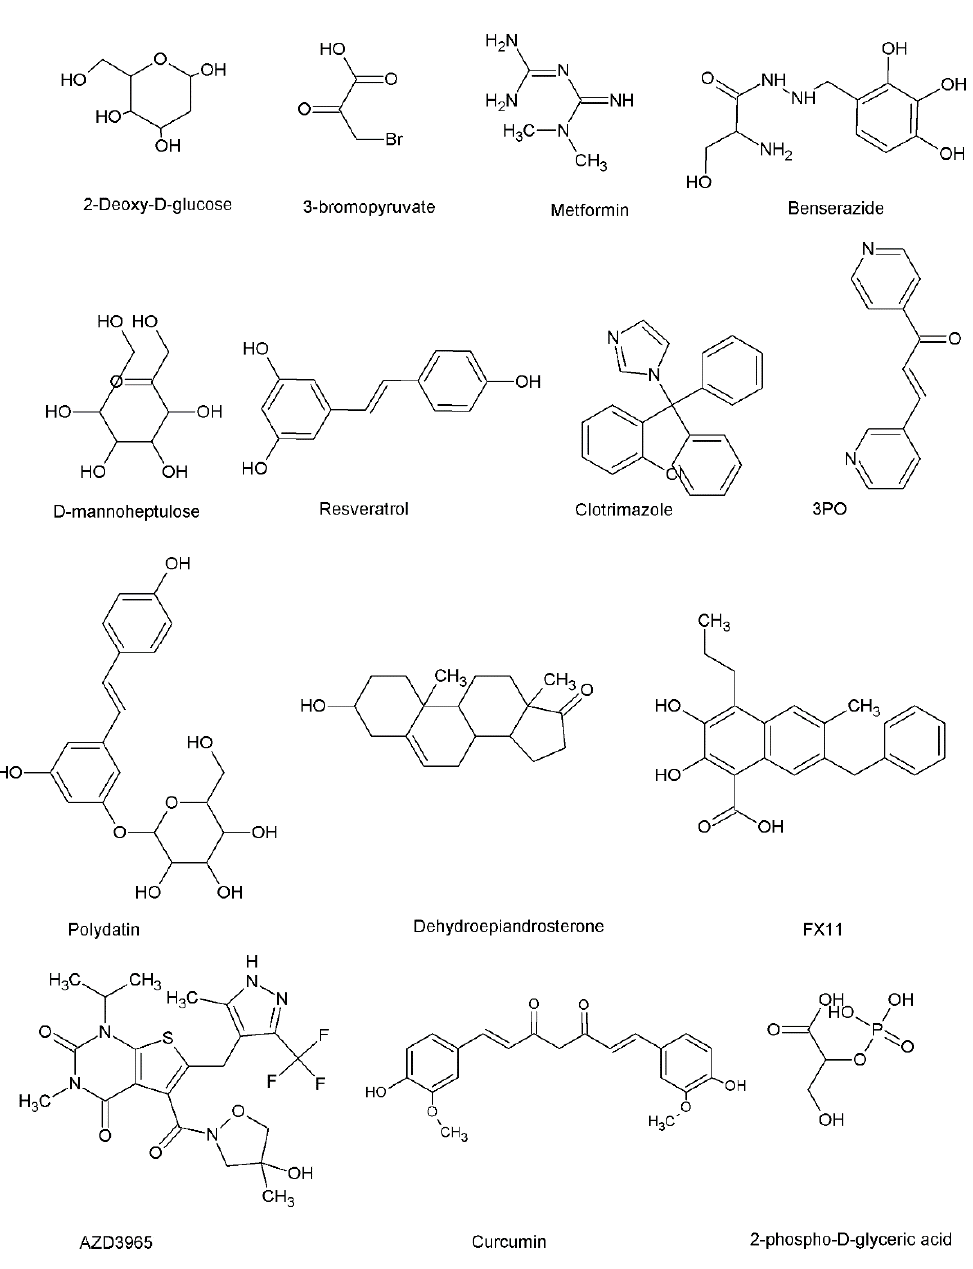
Figure 4. The chemical structures of some glycolytic enzyme inhibitors. 2-deoxyglucose, 3-bromopyruvate, metformin, benserazide, and D-mannoheptulose are HK inhibitors. Resveratrol, clotrimazole, and 3PO are PFK1 or PFKFB3 inhibitors. Polydatin and dehydroepiandrosterone are G6PD inhibitors. FX11 is an LDH inhibitor. AZD3965 is an MCT inhibitor. Curcumin is a well-